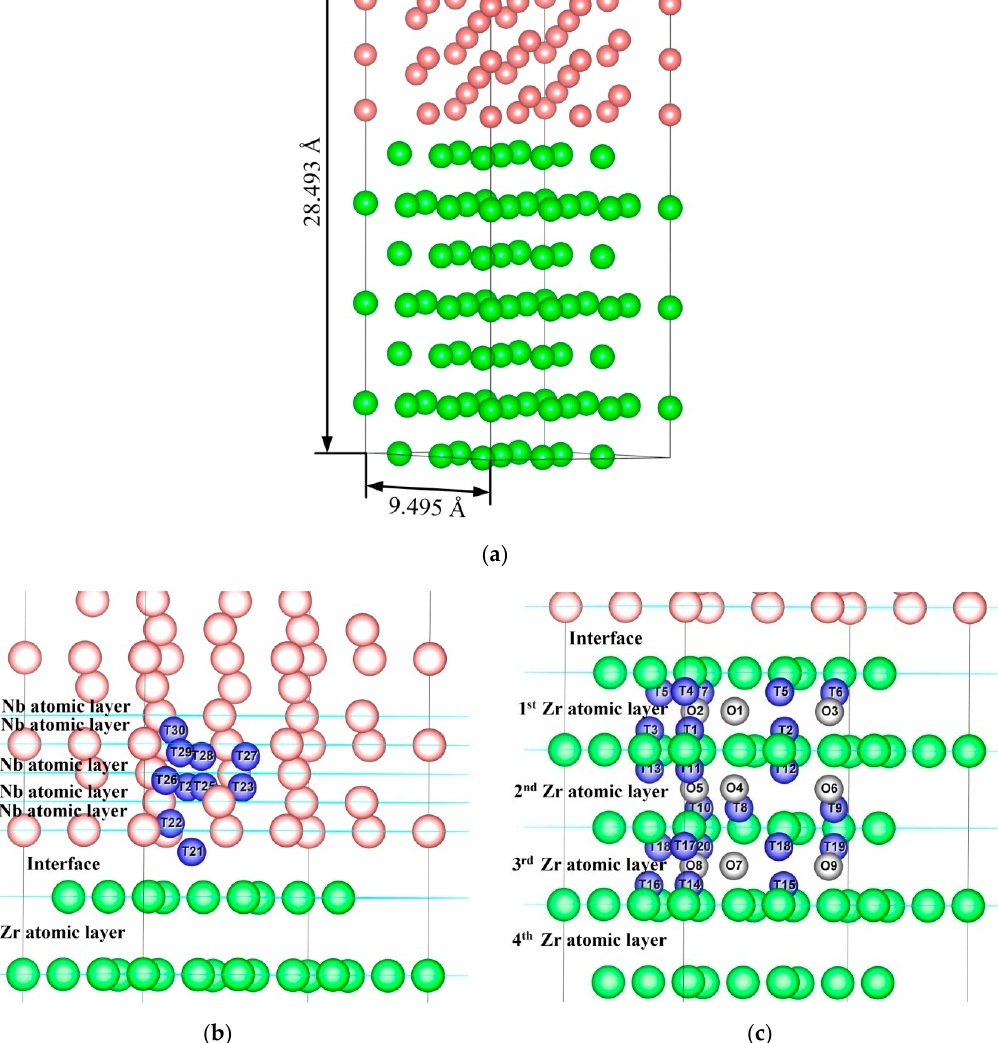
Figure 2. The supercell of Zr 63 Nb 40 multilayer structures ( a ) and positions of the considered interstitial sites in the Zr 63 Nb 40 supercell: ( b ) in Nb layer, ( c ) in Zr layer. Zirconium atoms are green, niobium atoms are pink, octahedral sites are grey, and tetrahedral sites are blue.